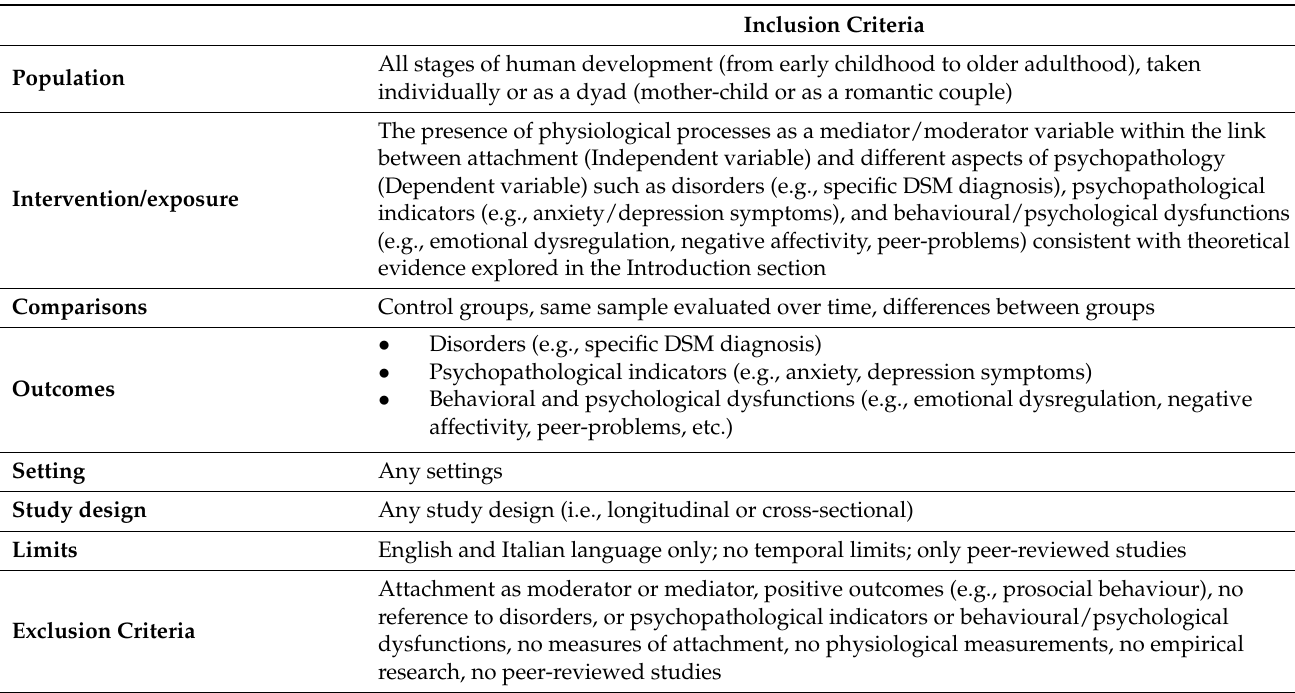
Figure 1. Flow chart for search strategy. Table 2. PICOS